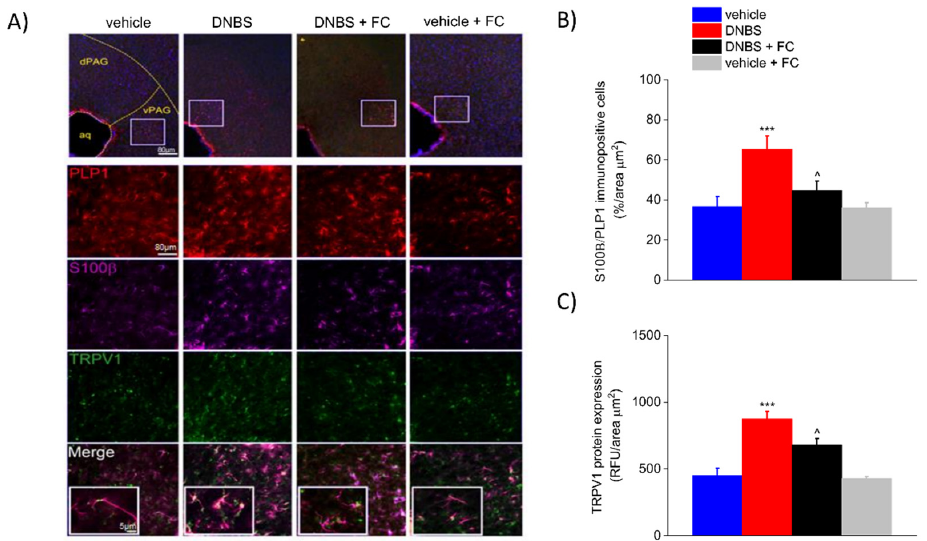
Figure 7. Effect of systemic fluorocitrate on S100 β and TRPV1 increased expression in the periaqueductal grey area of DNBS rats at day 7 ( A ) Representative images show the expression of PLP1 (red), S100 β (purple), and TRPV1 (green) in the periaqueductal grey area and ( B , C ) relative immunolabeling quantification at day 7 after colitis induction. Data were analysed by one ‐ way ANOVA and Bonferroni post ‐ hoc. Results are expressed as a mean ± SEM of the percentage of PLP1 immunopositive cells that express S100 β per area unit ( μ m 2 ) of n assessments. Results about TRPV1 expression are expressed as average relative fluorescence units (RFUs) ± SEM per area unit of ( μ m 2 ) of n assessments. *** p < 0.001 vs. vehicle and ^ p < 0.1 vs. DNBS. Original magnification: 4×, 10×, and 40×. Scale bars: 5 and 40 μ m.